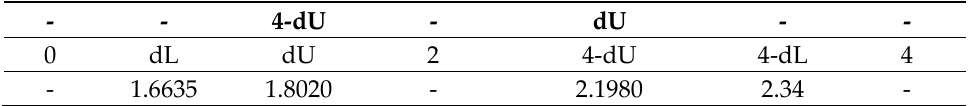
Figure 22. Test values for the Darbin–Watson statistic.